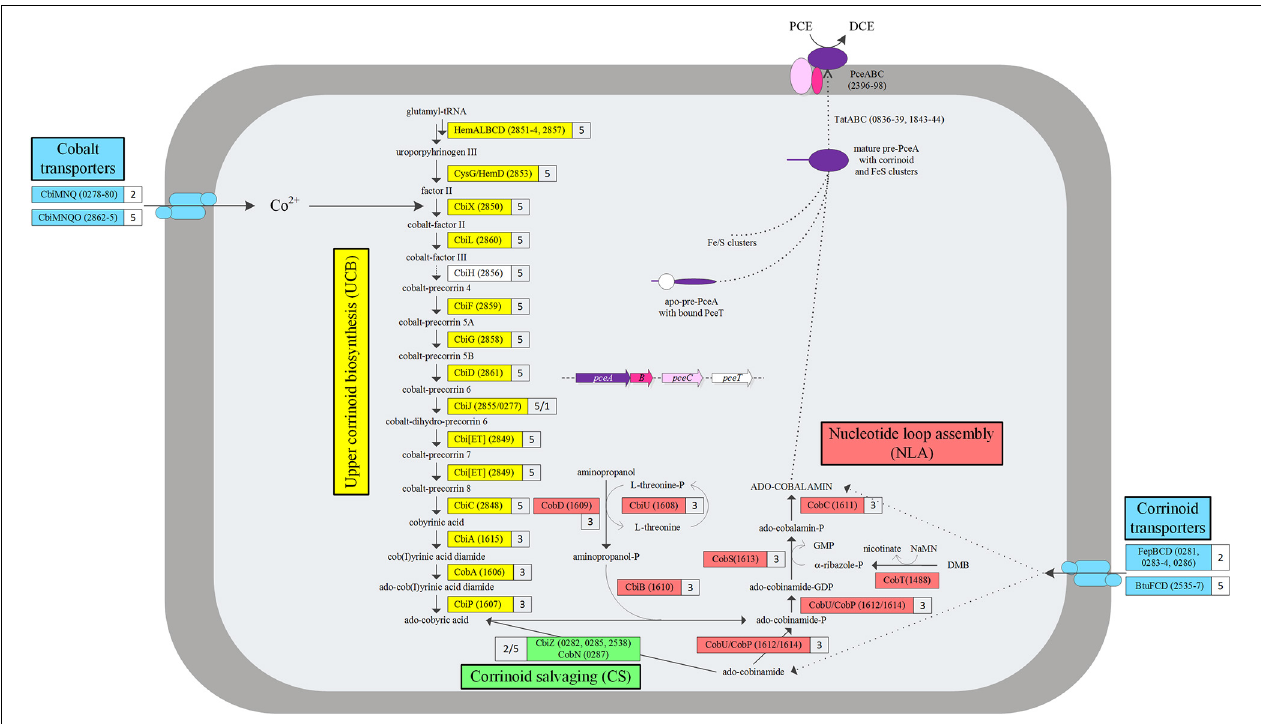
FIGURE 1 | Predicted corrinoid biosynthesis pathway of D. restrictus . Based on the genome annotation, a map of the corrinoid biosynthesis was predicted including four pathways: the upper corrinoid biosynthesis (UCB, in yellow), the nucleotide loop assembly (NLA, in red), cobalt and corrinoid transporters (in blue) and corrinoid salvage (in green). The PCE reductive dehalogenase (PceA and associated proteins PceB and PceC) is also depicted.